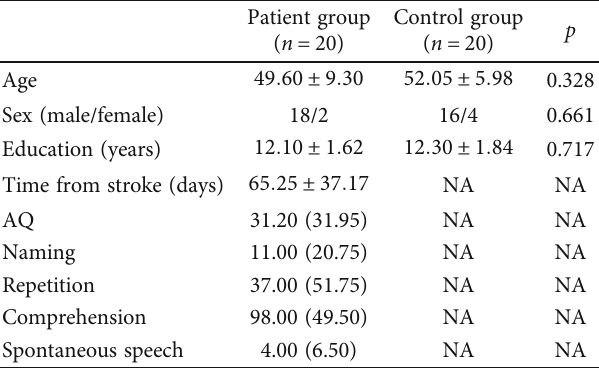
Table 1: Demographic data and language